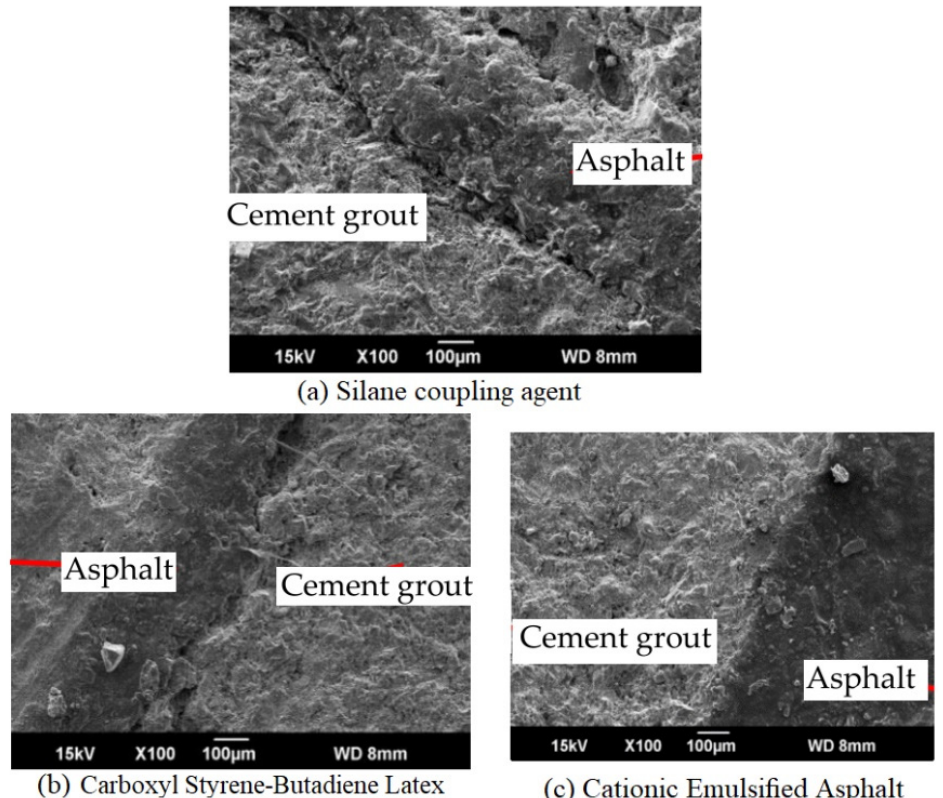
Figure 8. Effect of interface modifiers on grout–asphalt adhesion [101].